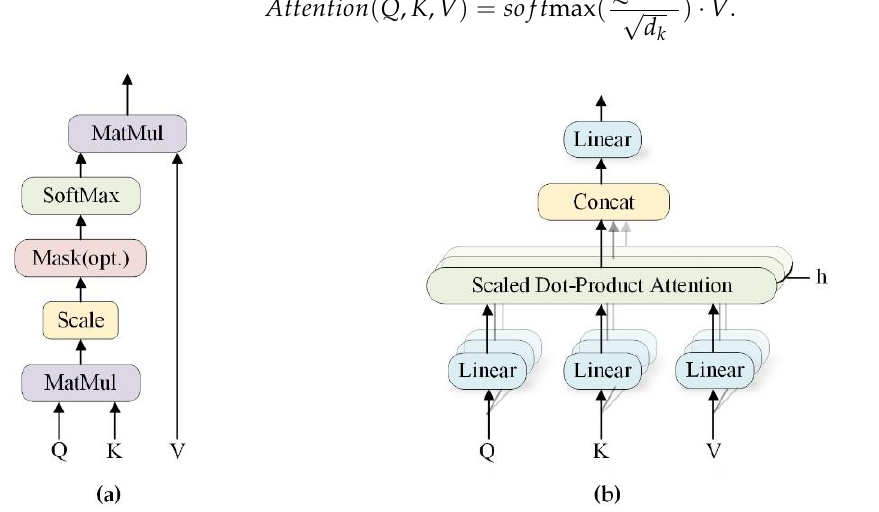
Figure 4. Structure of Self-Attention Mechanism. ( a ) Scaled Dot-Product Attention; ( b ) Multi-Head Attention.